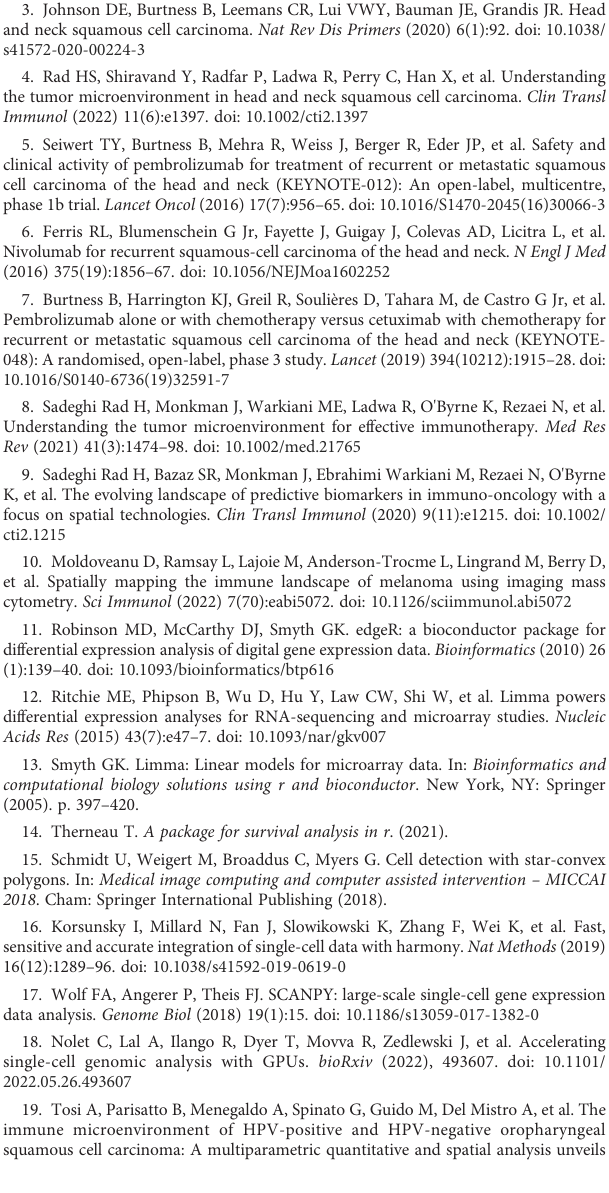
SUPPLEMENTARY FIGURE 4 CD20 expression and association with survival. Kaplan-Meier survival curve visualizing the relationship between CD20 expression of patients ’ survival.